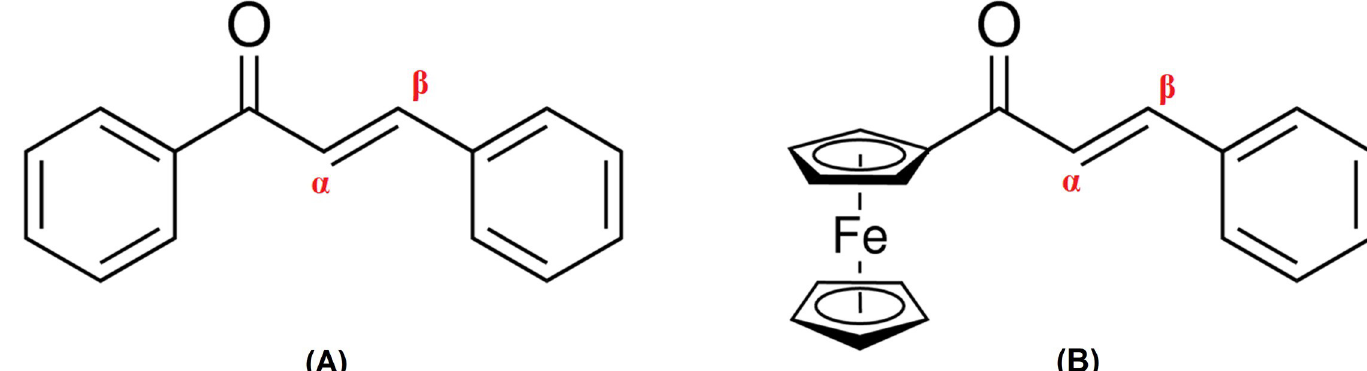
Fig 1. General structure. (A) Chalcone. (B) Ferrocenyl